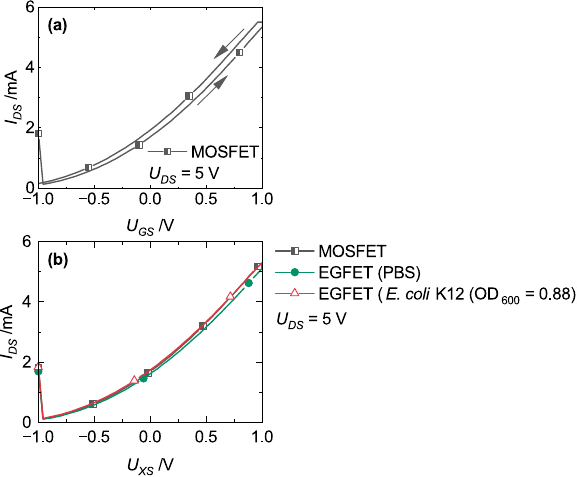
Figure 5. ( a ) Transfer characteristic of the MOSFET without the sensing area (squares) in comparison to ( b ) EGFETs contacted with a PBS-solution (circles) or a bacteria suspension (triangles) on the porphyrin- functionalized sensing area. The measurement results are shown only in forward manner for a clear overview ( b ) due to the almost identical characteristics of the EGFETs compared to the MOSFET results presented in ( a ).